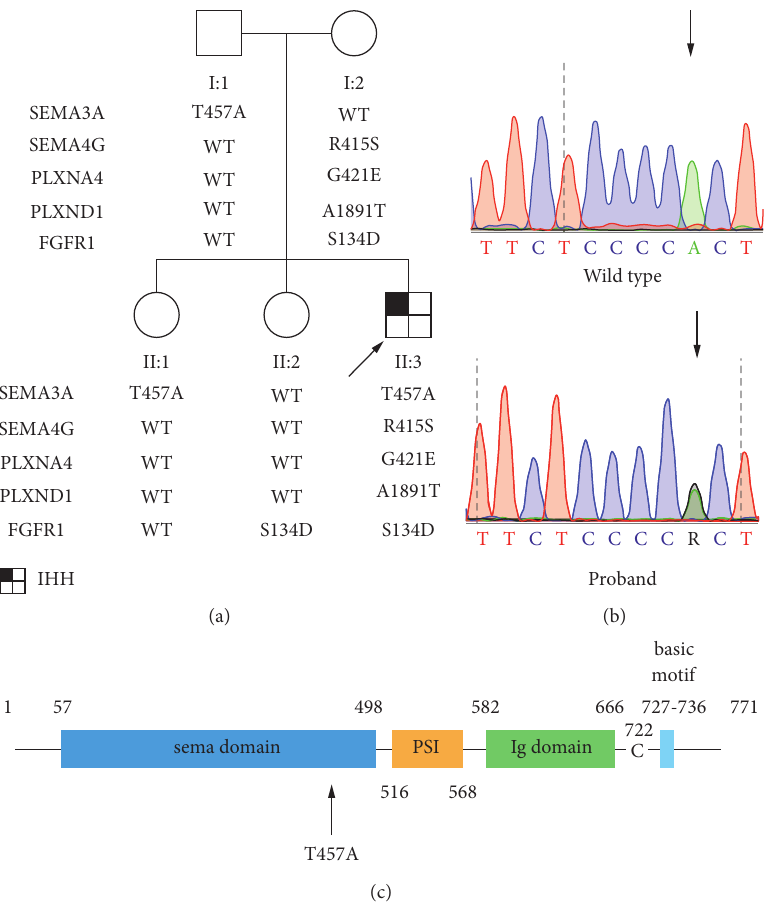
Figure 1: A novel SEMA3A variant screened in IHH patients. (a) Pedigree analysis of the proband. The proband is indicated by a black arrow. Circles and squares suggest women and men, respectively. (b) Sequence analysis of WT (top) and SEMA3A mutation (bottom). The arrow above the chromatogram indicates the codon affected by the variant. (c) The location of the T457A variant. SEMA, semaphorin domain; PSI, plexin/semaphorin/integrin domain; Ig, immunoglobulin-like domain; C, cysteine residue; IHH, idiopathic hypogonadotropic